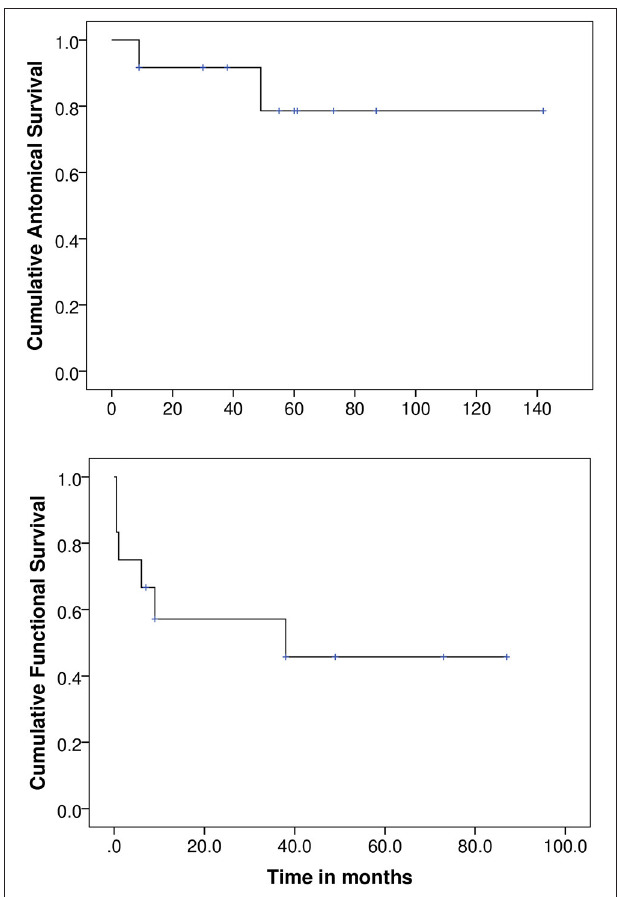
FIGURE 1 | Anatomical and functional survival